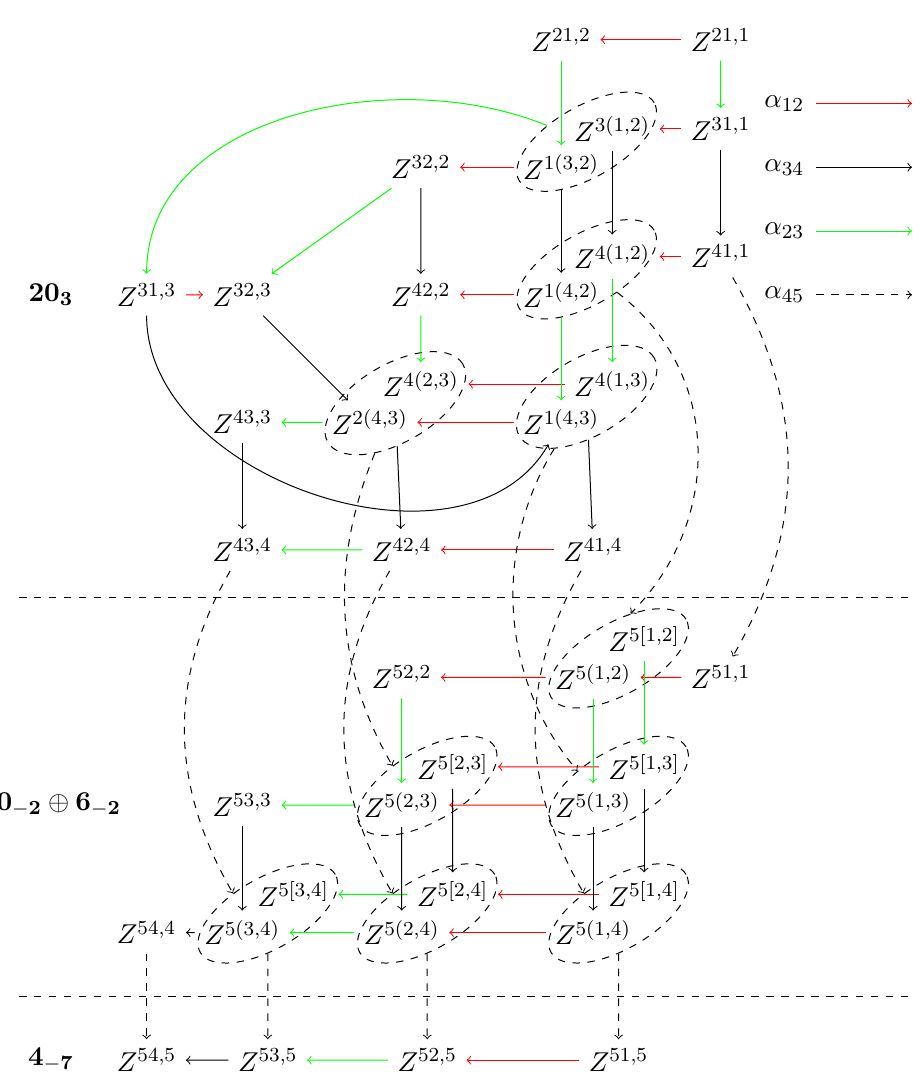
Figure 4 . Weight diagram of the 40 of sl (5) with weights arranged into irreducible representations upon the decomposition SL(5) ! SL(4) (cid:2) GL(1) when the root (cid:11) 45 is deleted. The components Z ab;c with non-zero symmetric and antisymmetric parts in f b; c g correspond to vectors of the same weight which are collected in dashed ellipses. In the case of 10 (cid:0) 2 (cid:8) 6 (cid:0) 2 the symmetric and antisymmetric parts belong to di(cid:11)erent representations of SL(4). The action of di(cid:11)erent roots is again denoted by di(cid:11)erent colours and the direction of the arrows show the lowering of a weight.